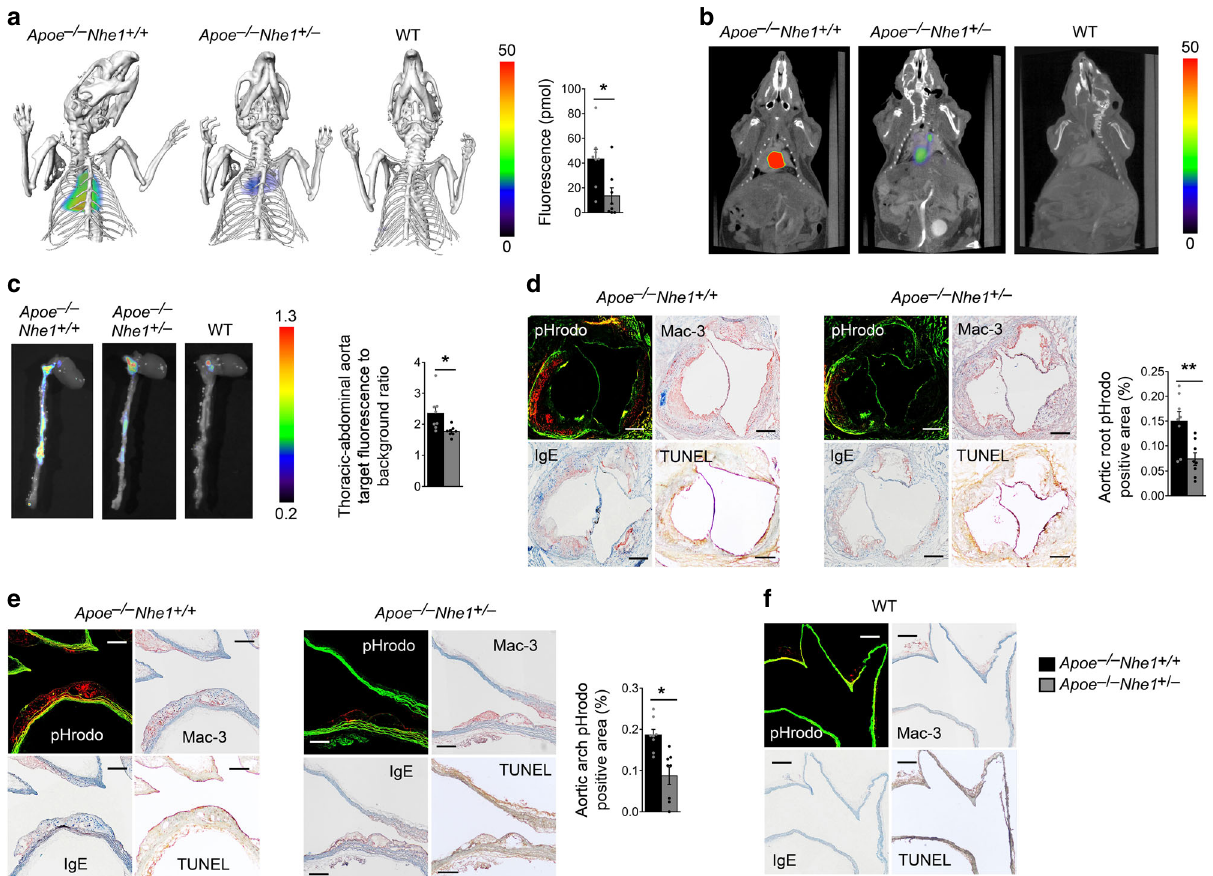
Fig. 7 Mouse atherosclerotic lesion FMT-CT imaging and veri fi cation. FMT-CT images and fl uorescence quanti fi cation a and representative FMT images b of live atherosclerotic Apoe – / – Nhe + / + ( n = 8) and Apoe – / – Nhe + / – mice ( n = 8) and healthy WT mice ( n = 4). c FMT images and fl uorescence quanti fi cation of ex vivo thoracic-abdominal aortas from atherosclerotic Apoe – / – Nhe + / + and Apoe – / – Nhe + / – mice and healthy WT mice. pHrodo